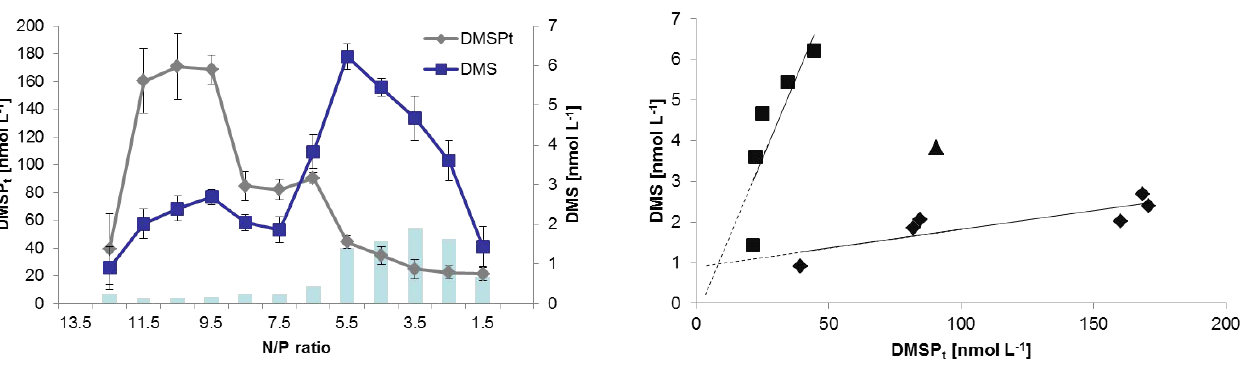
Fig. 6. N:P ratio vs. DMSP t (grey diamonds) and DMS (blue squares) at 5m depth. N stands for the sum of dissolved nitrate and nitrite, and P stands for phosphate. Blue bars show DMS:DMSP t ratios.